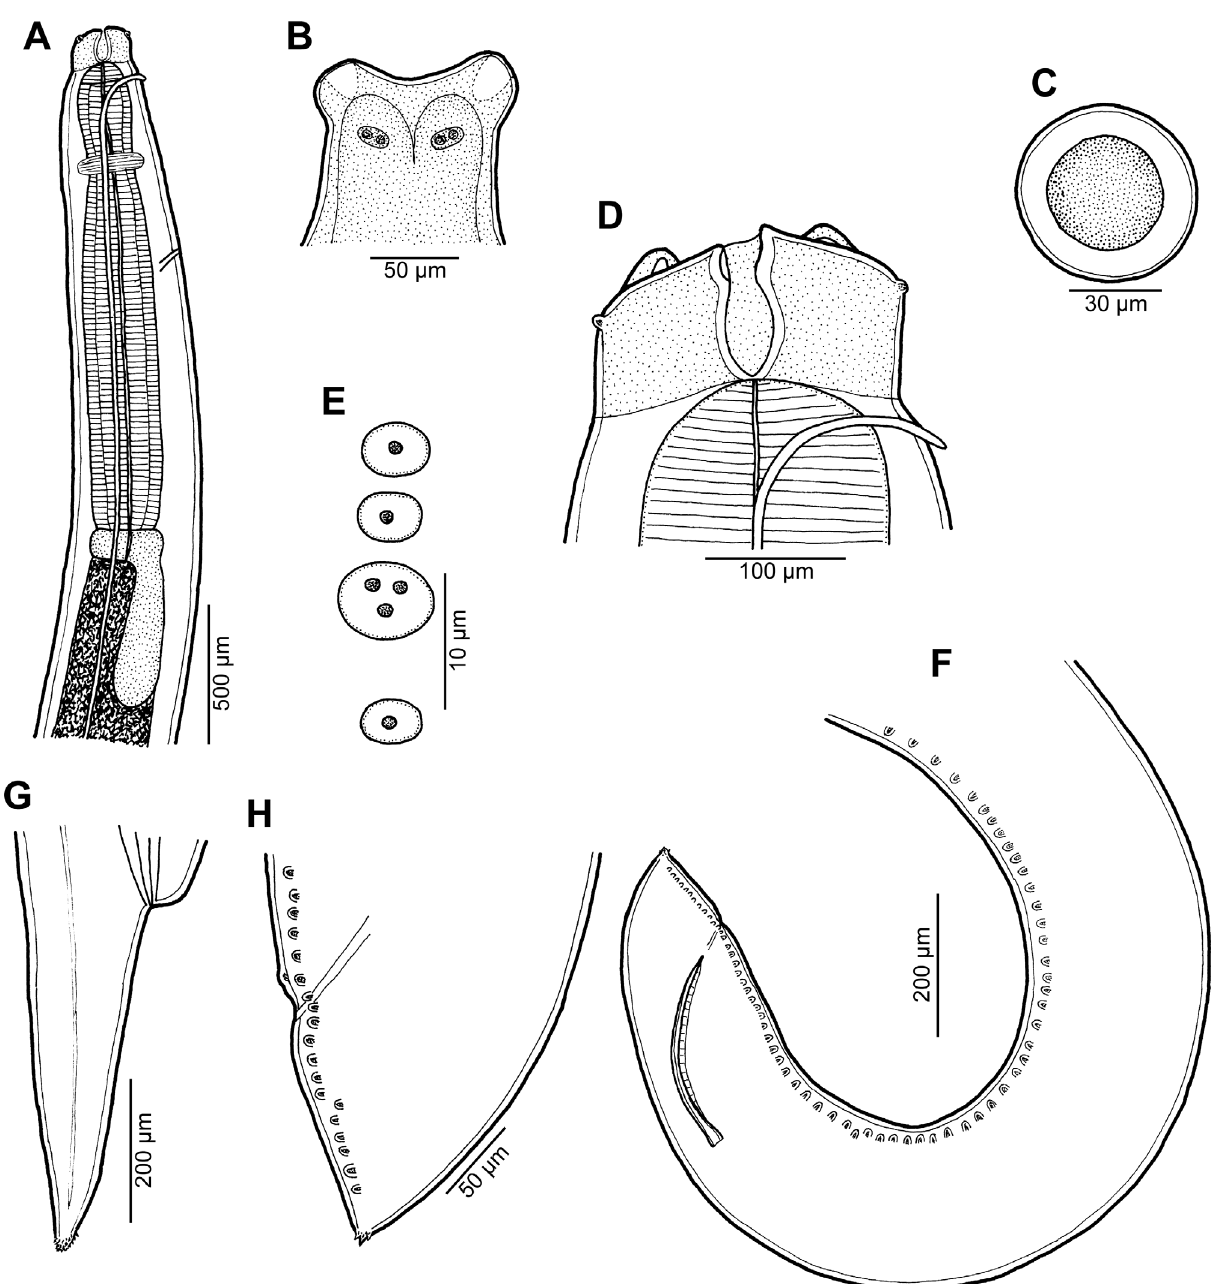
Figure 9. Raphidascaris ( Ichthyascaris ) euani n. sp. ex Gymnocranius euanus . (A) Anterior end of gravid female, lateral view; (B) dorsal lip; (C) egg; (D) cephalic end of female, lateral view; (E) postanal papillae of four posteriormost pairs on one side of body; (F) posterior end of male, lateral view; (G) tail of gravid female, lateral view; (H) caudal end of male, lateral